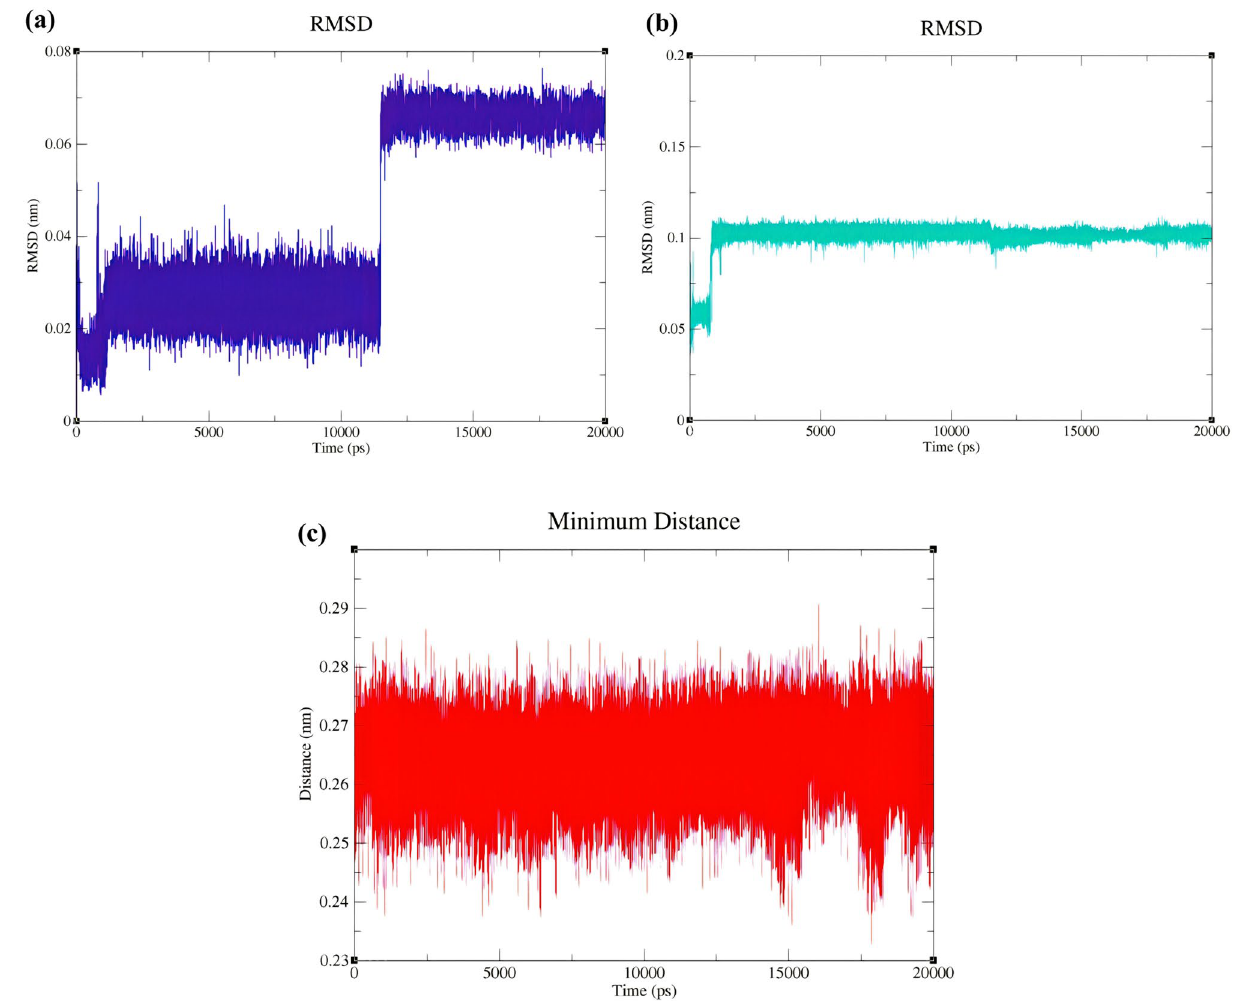
Figure 4. BMIM backbone RMSD (a) and IBU backbone RMSD (b) in the structure of [(BMIM) (IBU)] IL. (c) The plot of average of the minimum distance (nm) between BMIM and IBU against time (ps) during 20 ns of molecular dynamics